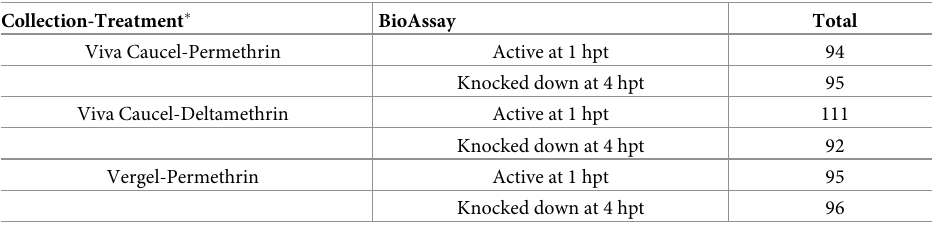
Table. Gene-wise association scores above the cut-off were mapped relative to each gene’s physical position for each collection (Fig